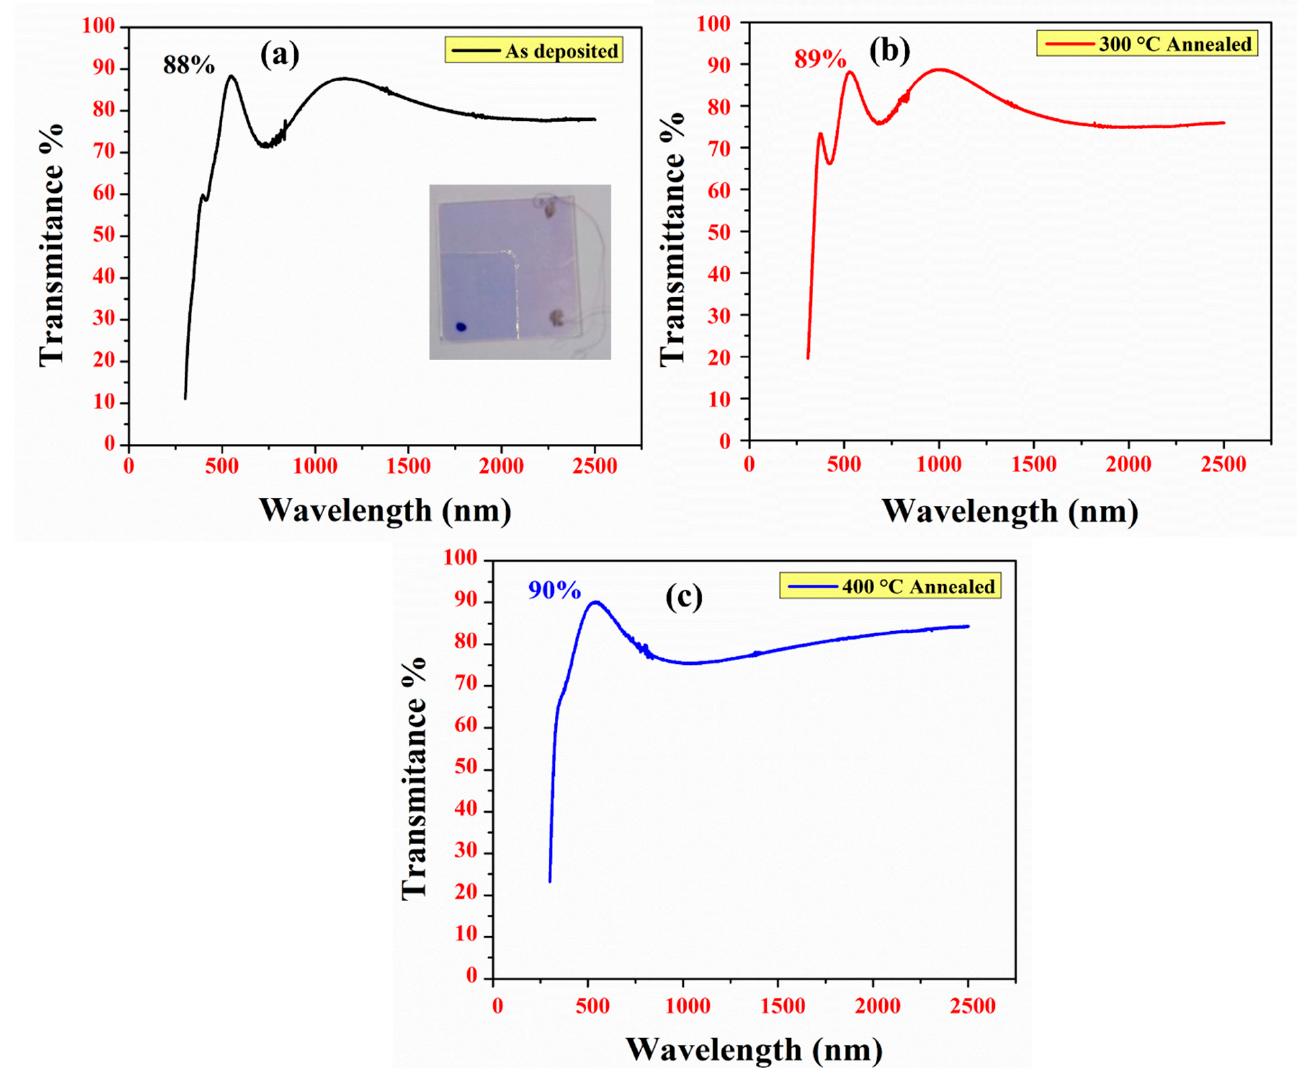
Figure 2. Transmittance spectra of multi-layered HfO 2 /V 2 O 5 /HfO 2 thin films: ( a ) as-deposited; ( b ) annealed at 300 °C; ( c ) annealed at 400 °C.